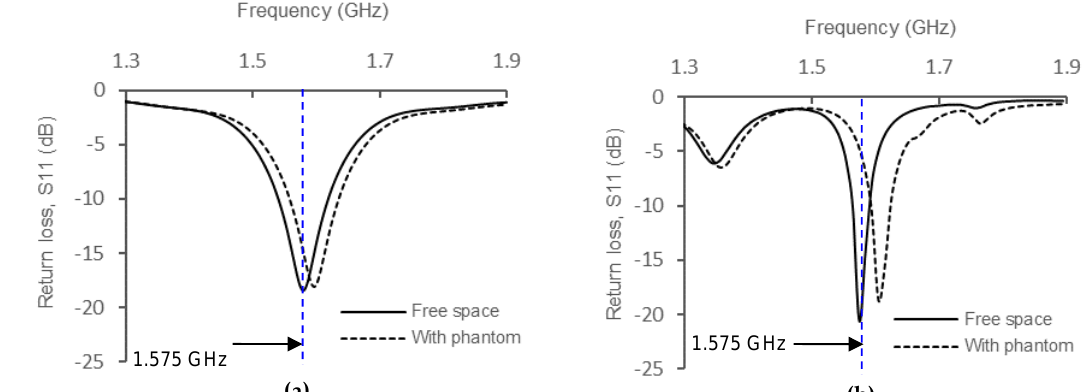
9 of 17 Figure 10. ( a ) Measurement configuration for the radiation pattern, showing the starting point of θ and  ; ( b ) Antenna configuration in free space (Case A); ( c ) Antenna configuration in the presence of the muscle phantom (Case B). Readings were recorded at every 2  for both  and  orientation. Comparison of S 11 between measured and simulated results are shown in Figure 11. As predicted, the resonant frequency shifted slightly to the right when the antenna was tested in the presence of the muscle phantom, and the effect was significant during measurement. This effect is called detuning effect, and is calculated based on equation 4: Detuning % = 100  o fDetuning (4) By comparing the amount of frequency detuning to the desired resonant frequency through simulation results, the phantom with the lowest  r and  , which is body fat has the smallest detuning percentage (1.14%) as compared to the phantoms with higher  r and  (e.g., muscle and blood) which give 1.4% each. This effect is due to the changes in the antenna’s internal impedance, Z in when it was placed on a material having high loss (tan δ ) and significant  value. The correlation between the presence of lossy dielectric materials for various ε r to Z in will be discussed in the next section. Figure 12 shows the radiation pattern of the e-textile antenna for both cases in E-plane and H-plane,